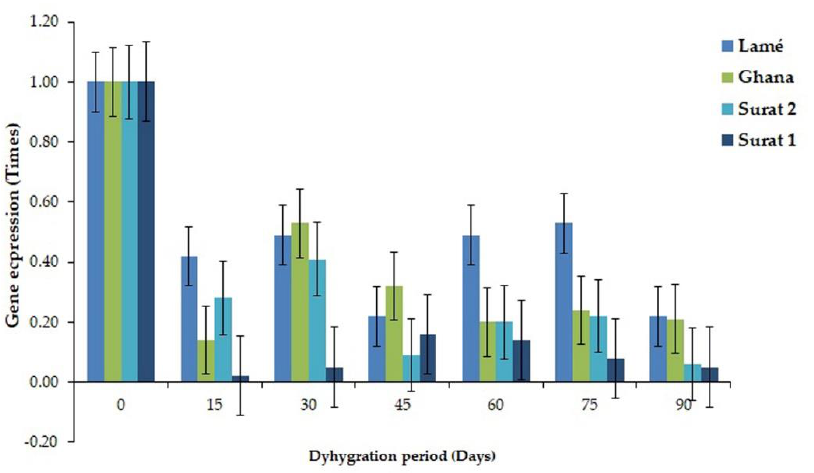
Figure 5. Gene expression value of transcription factor bHLH106-like gene in a leaf of different oil palm varieties at different periods of water deficit.